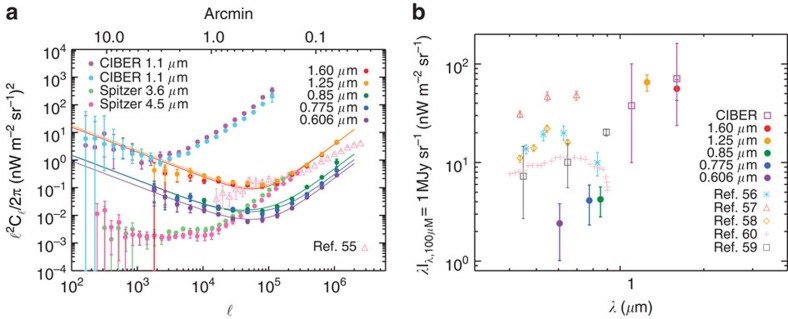
Various autospectra and the spectral energy distribution of diffuse galactic light.(a) CANDELS corrected power spectra plotted against the CIBER16, Spitzer15 and NICMOS54 measurements (see also ref. 34 for more recent NICMOS measurements). The power spectrum resulting from the NICMOS analysis was measured from a MultiDrizzle map and has not been corrected for the transfer function and mode-coupling matrix resulting from source masking as discussed in our Methods section. Therefore we show it as a comparison but do not use it in our modelling. The error bars are 1σ uncertainties that account for all sources of noise and error, including map-making, calibration, detector noise, and cosmic variance associated with finite size of the survey. (b) Optical and infrared diffuse galactic light (DGL) spectrum. The CANDELS points are taken from the DGL model components at 104≤ℓ≤3 × 104, and the CIBER points are taken directly from Fig. 2. of ref. 16 where they subtract off the shot noise component from their data. The galactic latitude for the optical points are |b|≃39°,32°,41°,40° for the points labelled Witt55, Paley56, Ienaka57 and Guhathakurta58. The Brandt59 points are modeled over the full sky. GOODS-S is at a galactic latitude of |b|=54°.